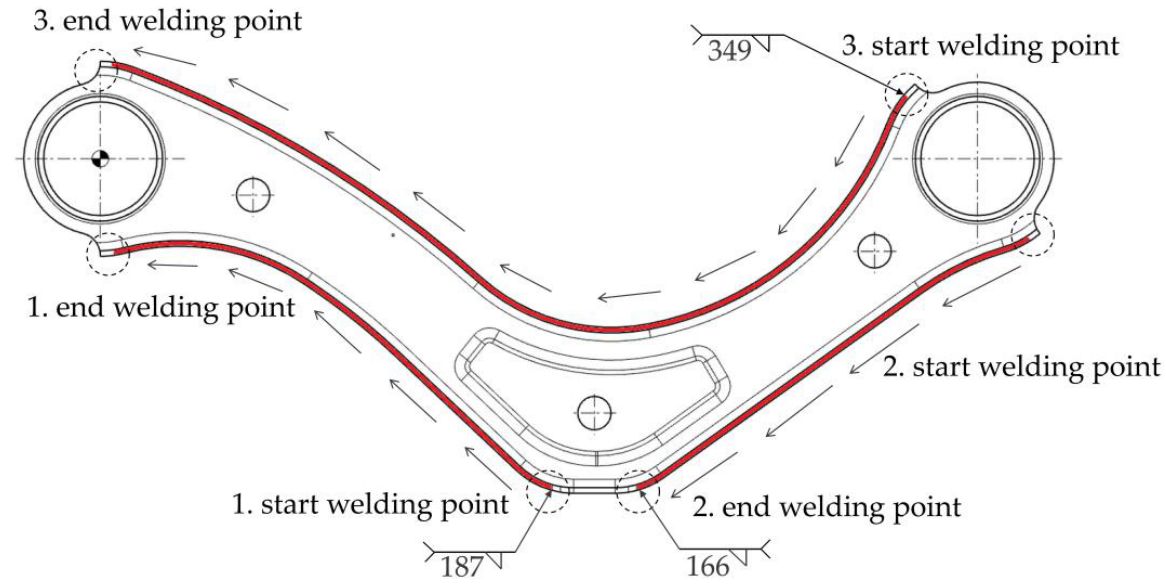
Figure 2. Location of welds and their order during welding [36]. The experiment was carried out according to Table 3, with individual measurements taken in order according to column n E . The random order of the performed experiments ( n E represents the random order) ensures that the assumptions of the methodology of the design of experiment are met, which is necessary for the generalization of the results. Due to the impossibility of taking measurements at the mean value of the stamping dimension ( Z ), the monitored dimensions of the stampings were chosen at the lower and upper limits of the monitored interval. Table 3. Measurements — LR model and training (for ANN) data.